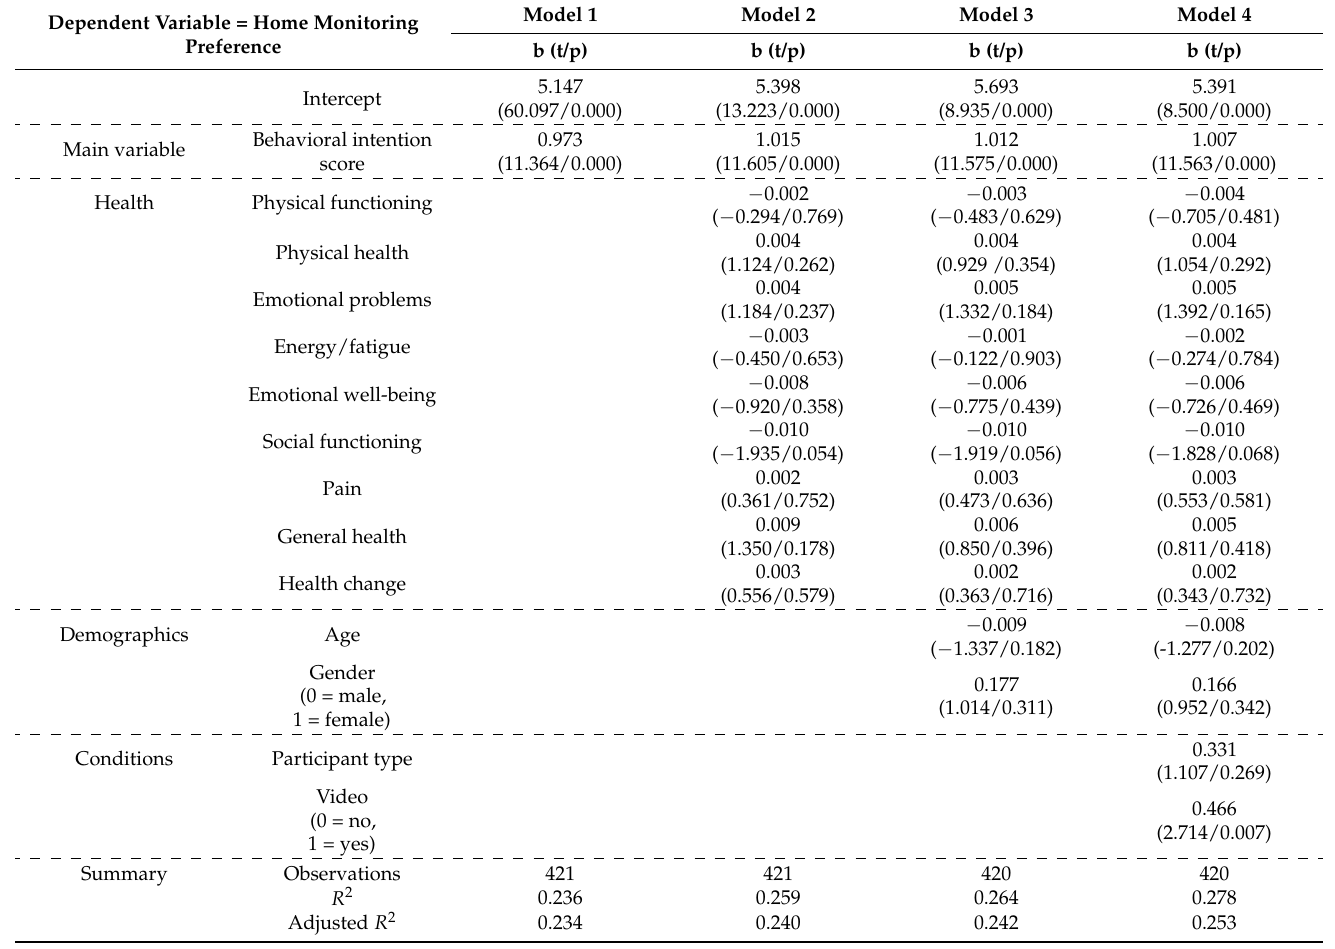
Table 4. Regression analysis among home monitoring preferences and various